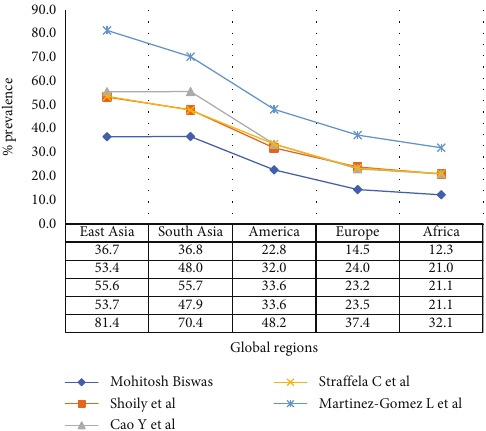
Figure 1: Global % prevalence of ACE2 SNV rs2285666 from di ff erent studies. Footnote: these are frequencies of the SNV rs2285666, genotypes G/A, and T/C admixed from various retrospective studies that used information from